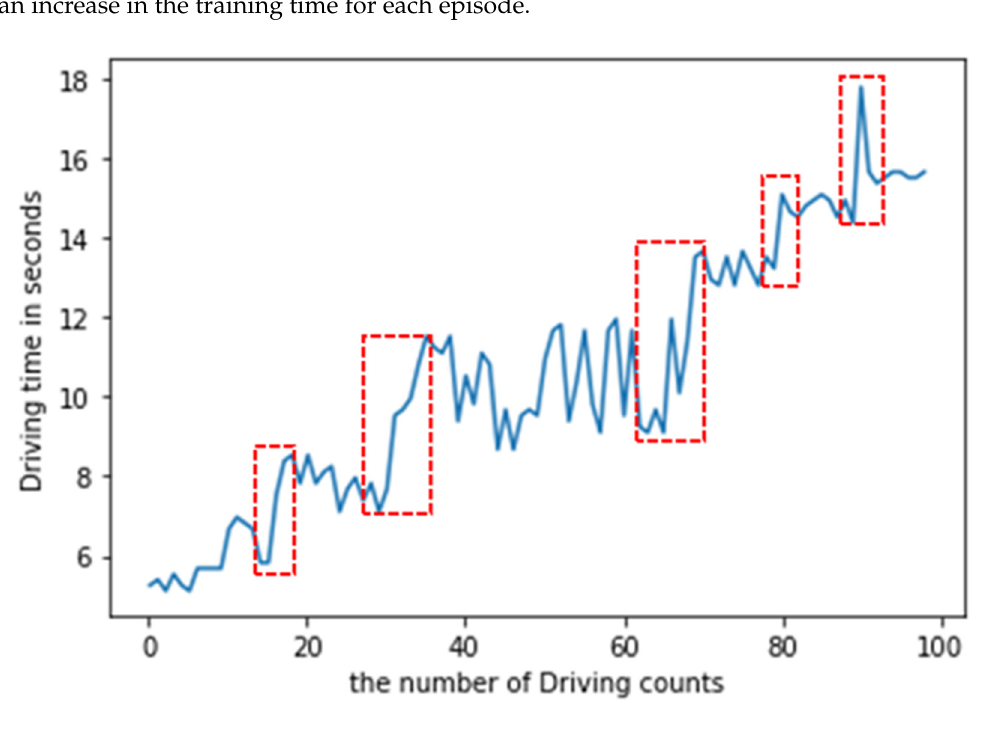
Figure 8. Time until collision results when using the collision prevention algorithm.